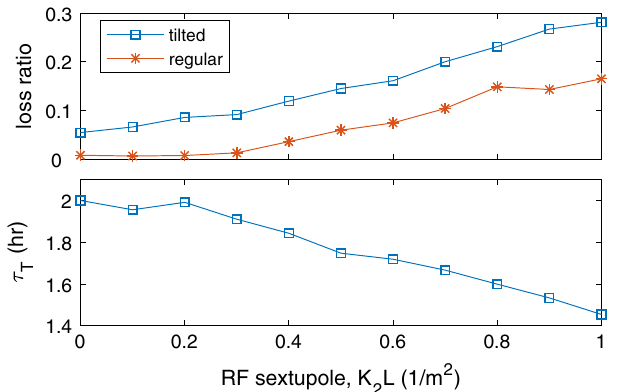
FIG. 7. The impact of rf skew sextupole to injection loss ratio (top) and camshaft Touschek lifetime (bottom). The deflecting voltage is V 1 ¼ 1